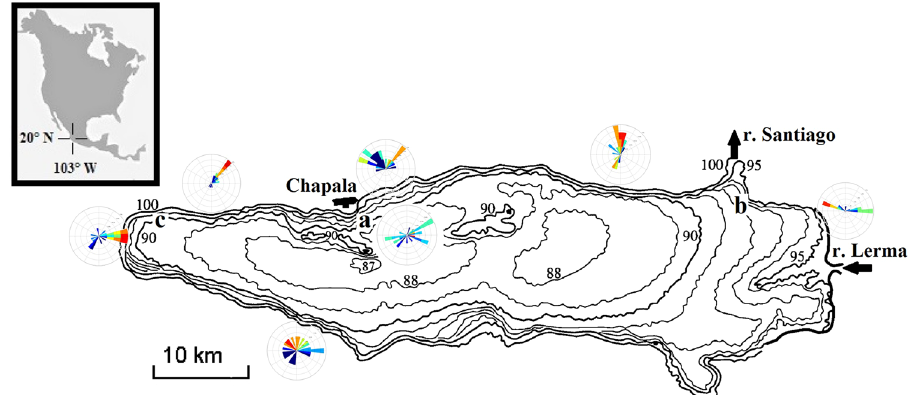
Figure 1. Bathymetric map of Lake Chapala, the value of the level curves are reported according to the local “Bench Mark” (isobaths) scale where the maximum storage water capacity equal to 7,897 Mm 3 (corresponding to isobaths 97.8 m that is 1523.80 m above sea level). The weather vane represents the distribution and average frequency of the wind direction from the network of the weather stations and measuring sites: ( a ) northeast, ( b ) east and ( c )